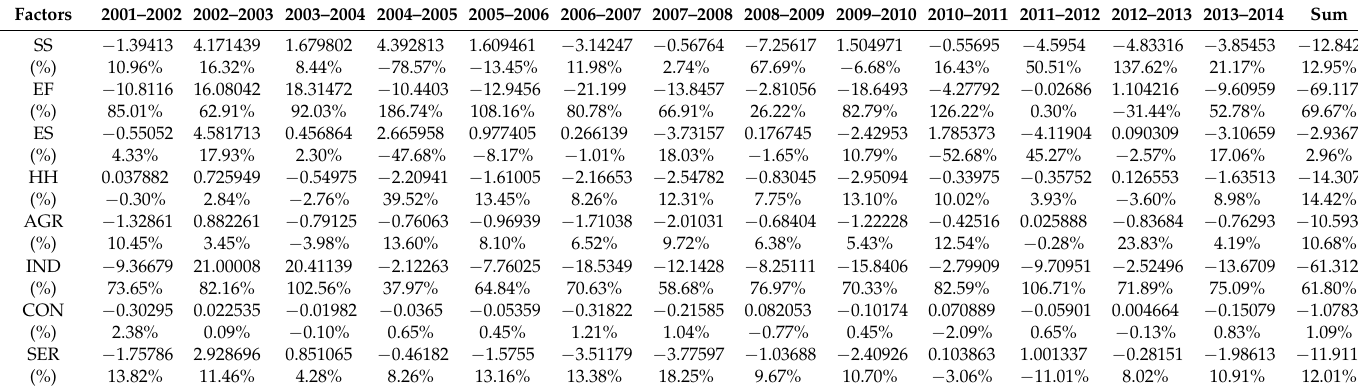
Table 3. Contributions of Each Factor or Sector (Unit: MT/Trillion